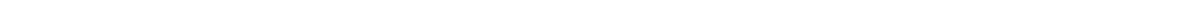
Fig. 2 Ectopic expression of MxB inhibits lytic replication of HSV-1 and HSV-2. a A549 human lung adenocarcinoma cells were engineered to stably express glutathione S -transferase (GST) or human MxB. A549-GST and A549-MxB cell lines were generated from clones with high gene expression. MxB protein expression and intracellular localisation was assessed by immunostaining. Nuclei were stained with Hoechst 33342. Scale bar, 20 µ m. b A549-GST and A549-MxB cells were transfected with non-targeting siRNA (siNT), siRNA targeting the 3 ′ -UTR of endogenous MX2 (siMxB UTR) or two different siRNAs targeting the coding sequence of endogenous and overexpressed MX2 (siMxB #1, siMxB #2). At 48 h post transfection, cells were lysed for immunoblot analysis of GST and MxB protein expression and MX2 silencing ef fi ciency. GAPDH served as a loading control. c – e A549-GST and A549-MxB cells were infected with IAV strain WSN (MOI = 0.5) for 24 h ( c ), VSV serotype Indiana (MOI = 0.5) for 16 h ( d ) or HAdV-C5 strain wt300 (MOI = 5) for 48 h ( e ). Viral output was measured by TCID 50 assay ( c , d ) or immuno fl uorescence assay ( e ). Bars indicate mean ± s.d., n = 3 – 4 biological replicates. Unpaired two-tailed Student ’ s t tests with log-transformed titres: NS p ≥ 0.05; * p < 0.05. f – i A549-GST and A549-MxB cells were transfected with the indicated siRNAs. At 48 h post transfection, cells were infected with HSV-1 strain MacIntyre or F (MOI = 0.05) for 24 h ( f , g ), recombinant strain C12 (MOI = 0.5) for 24 h ( h ) or HSV-2 strain G (MOI = 0.05) for 48 h ( i ). Viral output was measured by TCID 50 assay. Data are representative of three independent experiments. Bars indicate mean ± s.d., n = 3 biological replicates. ANOVAs modelling log-transformed titre with cell line and siRNA as explanatory variables: HSV-1 MacIntyre: cell line, F (1,16) = 86.442, p < 0.0001; siRNA, F (3,16) = 6.863, p = 0.003489; antagonising interaction, F (3,16) = 12.34, p = 0.000196. HSV-1 F: cell line, F (1,16) = 49.065, p < 0.0001; siRNA, F (3,16) = 6.653, p = 0.00399; antagonising interaction, F (3,16) = 8.102, p